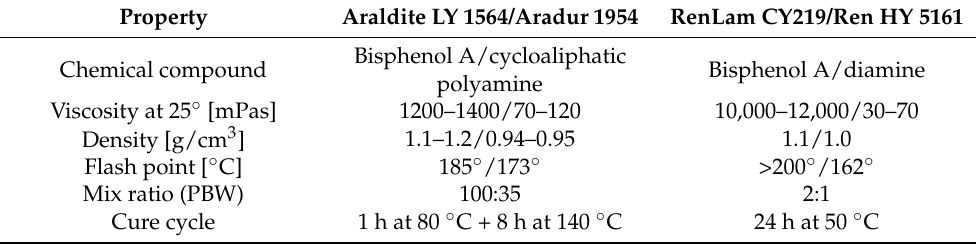
Table 1. Adhesives